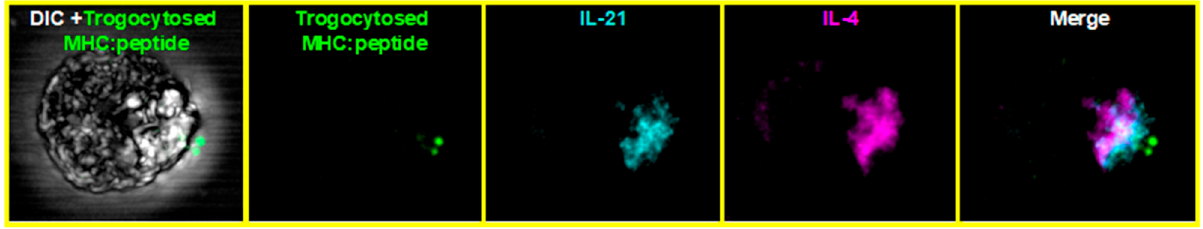
Figure 4. IL-4 and IL-21 were polarized toward trogocytosed MHC:peptide TCR transgenic cells incubated for 90 min with APCs expressing GFP-tagged MHC:peptide. Cells were recovered, permeabilized, and stained for intracellular IL-21 and